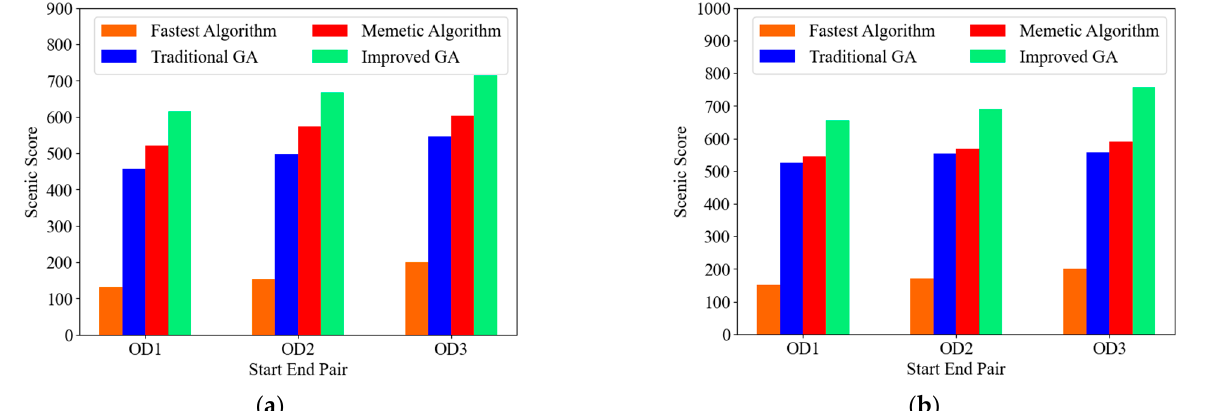
Figure 8. Comparison of scenic score under different start end pairs. ( a ) Xi’an; ( b ) Wuhan.